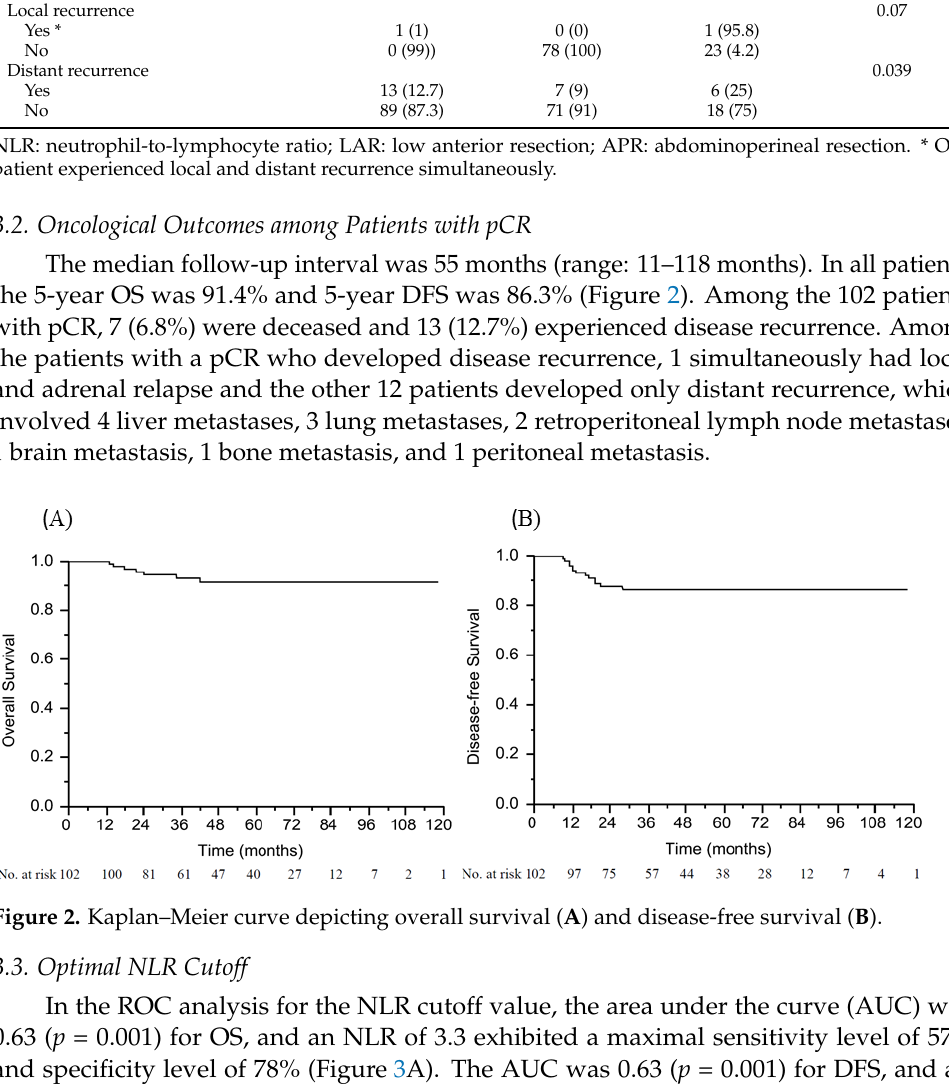
Figure 3. The area under the curve indicating optimal NLR cutoff value. ( A ) AUC for overall sur- vival, ( B ) AUC for disease-free survival. 3.4. Association between NLR Level and Clinical Variables The difference in clinical factors according to NLR level is detailed in Table 1. In general, 75 patients (73.5%) were assigned to the low-NLR group, and 27 patients (26.5%) were assigned to the high-NLR group. None of the clinical factors were discovered to be correlated with the NLR, except for tumor relapse status. Our results indicated that the high-NLR group was more likely to develop tumor recurrence ( p = 0.039). 3.5. Association between NLR Level and Survival Outcomes Our study revealed that patients with a pCR who recorded a high NLR exhibited poorer survival compared with other patients. The 5-year OS rates in the low-NLR (<3.2) and high- NLR (≥3.2) groups were 95.1% and 77.7%, respectively ( p = 0.014; Figure 4A).